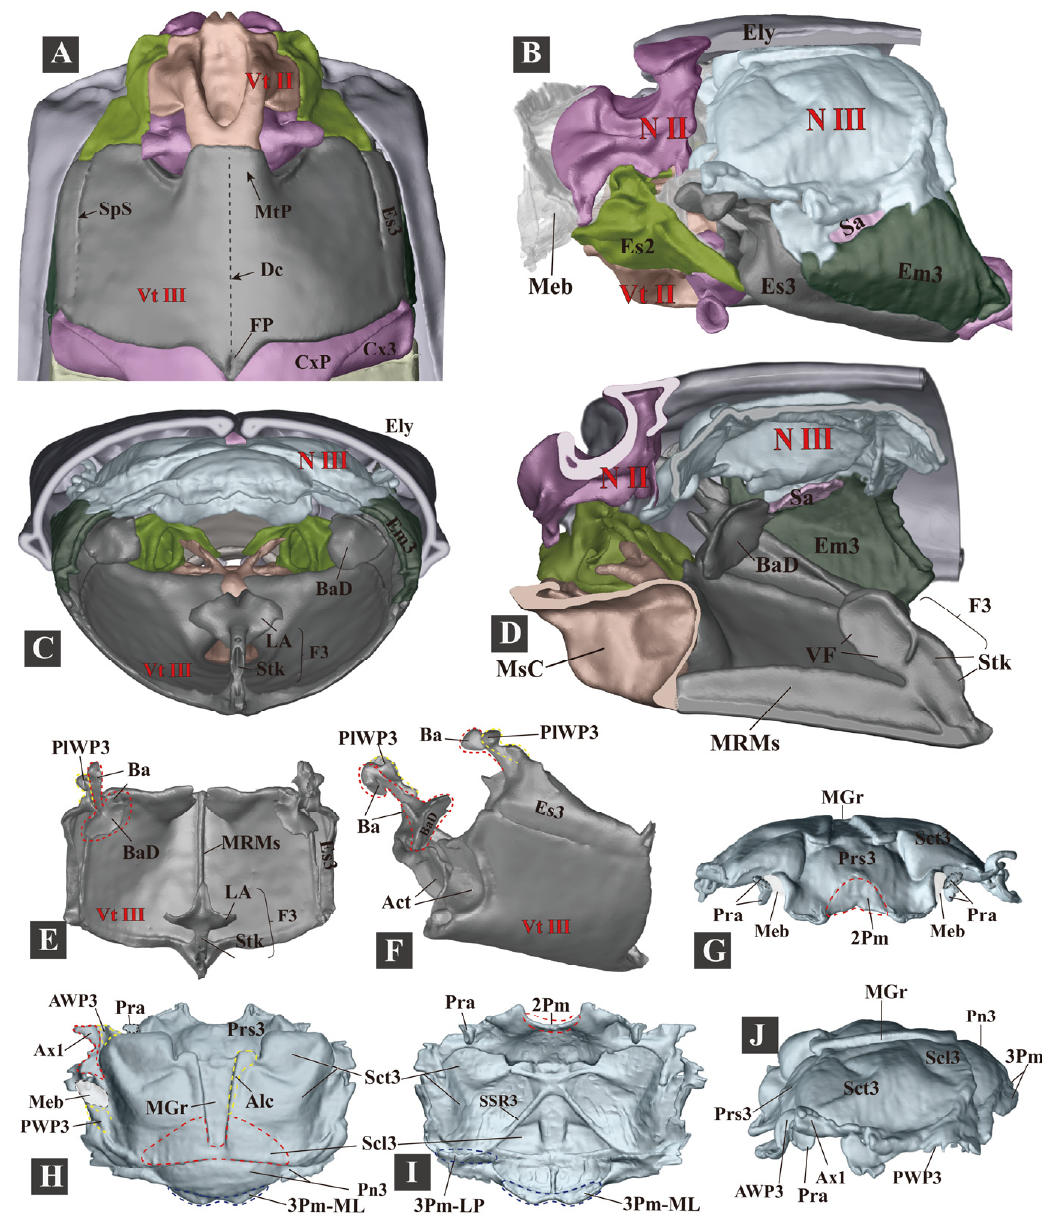
Figure 6. Three-dimensional reconstructions of the metathoracic skeleton of Campsosternus auratus . For abbreviations, see Section 2 ‘Materials and Methods’. ( A ) ventral view of the meso- and metatho- rax. ( B ) lateral view of the meso- and metathorax; the left elytron is removed. ( C ) caudal view of the meso- and metathorax. ( D ) mesal view of the meso- and metathorax cut in the sagittal plane. ( E , F ) dorsal and lateral views of the metaventrite. ( G – J ) frontal, dorsal, ventral, and lateral views of the